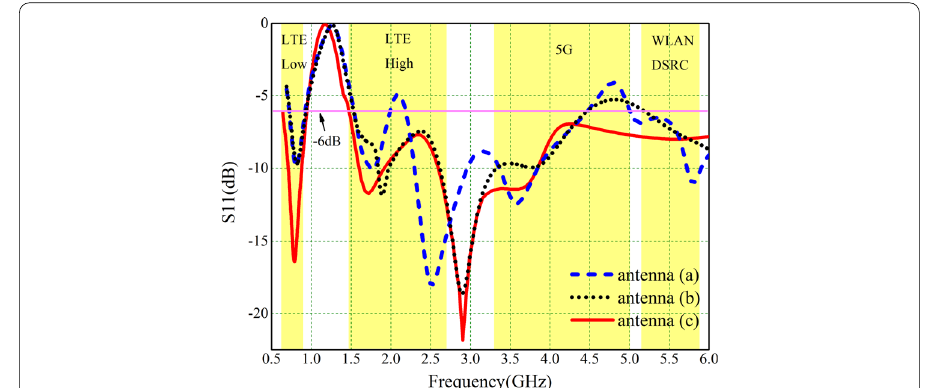
Fig. 6 S parameters of the rooftop antennas. Although all of the three types of antennas could meet the requirement of LTE low-frequency band, the 5G frequency band could only be covered by the antenna (c)